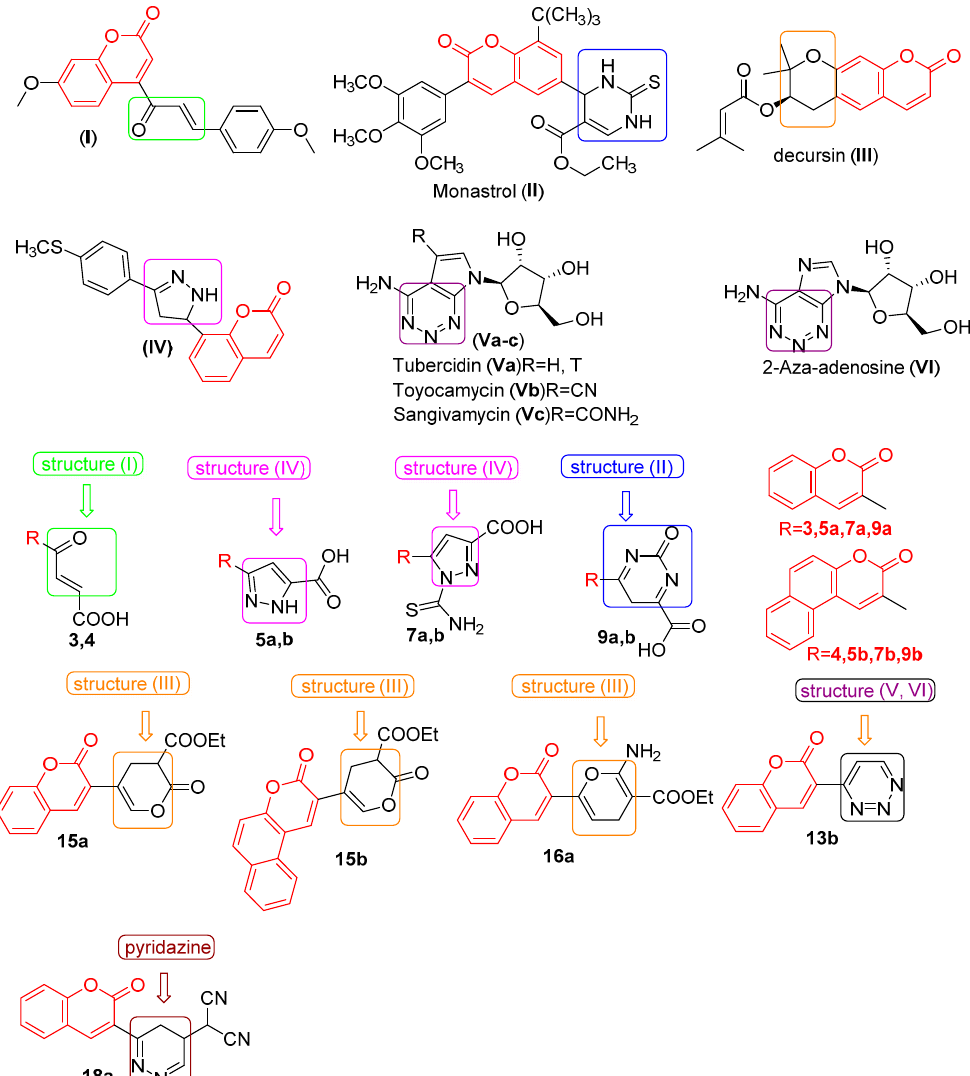
Figure 1. Structure of some anticancer derivatives ( I – VI ) and some of the designed target compounds 3 , 4 , 5a,b , 7a,b , 9a,b , 13b , 15a,b , 16a and 18a .